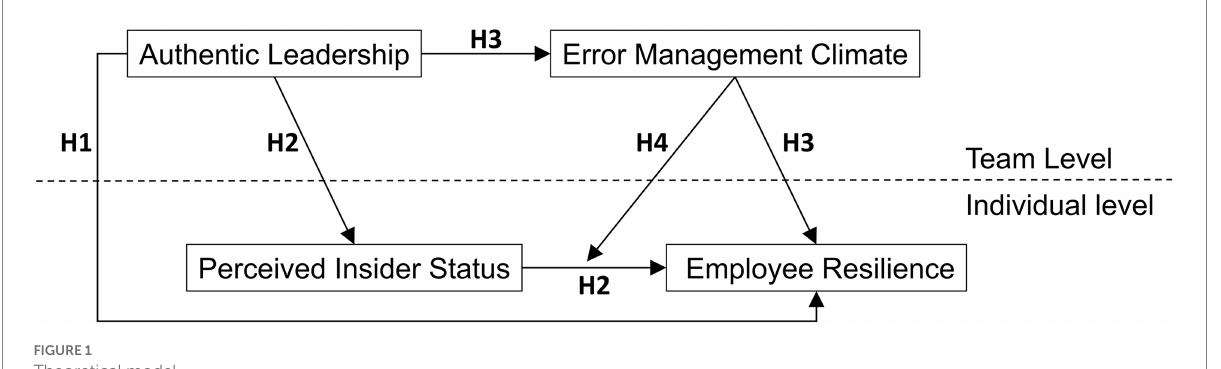
FIGURE 1 Theoretical